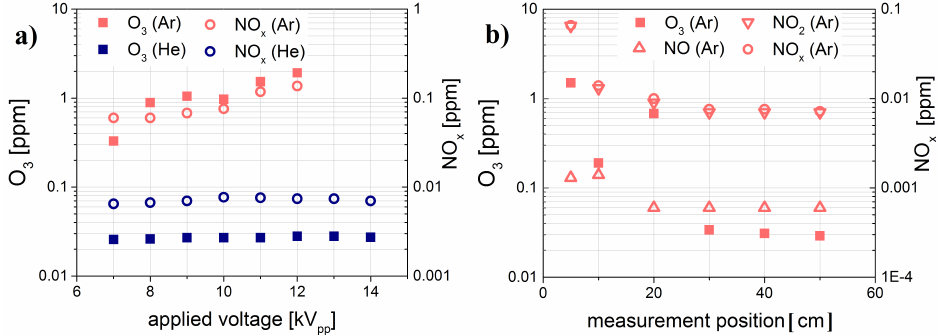
Figure 8. Distribution of ROS and RNS production for argon and helium operation for a conductive surface at d = 5 mm for different ( a ) applied voltages and ( b ) different measurement positions of the gas inlet at 8 kV pp